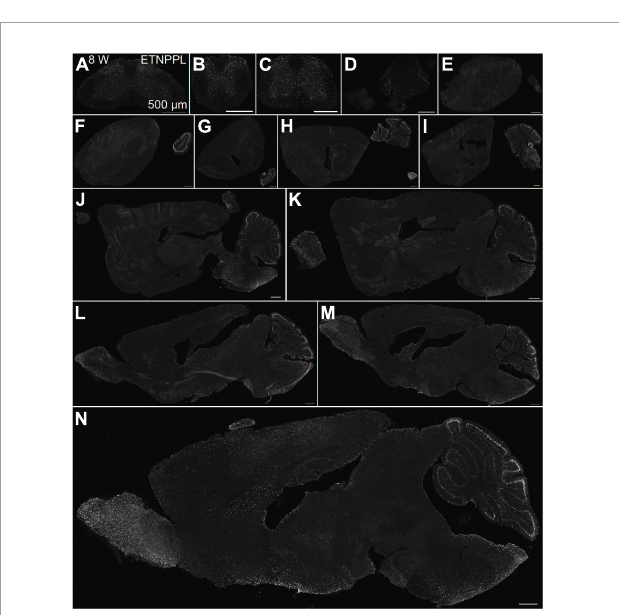
FIGURE6 Localization of ETNPPL in the whole brain in 8-week old mice. Coronal sections of the cervical cord (A) , thoracic cord (B) , lumbar cord (C) , or parasagittal section (approximately 400 µ m interval) of the whole brain (D–N) of 8 W female mice are shown. White indicates the ETNPPL signal revealed by IHC. Scale bars: 500 µ m. The section images were appropriately rotated and cropped and the background was filled with black to minimize unnecessary space.